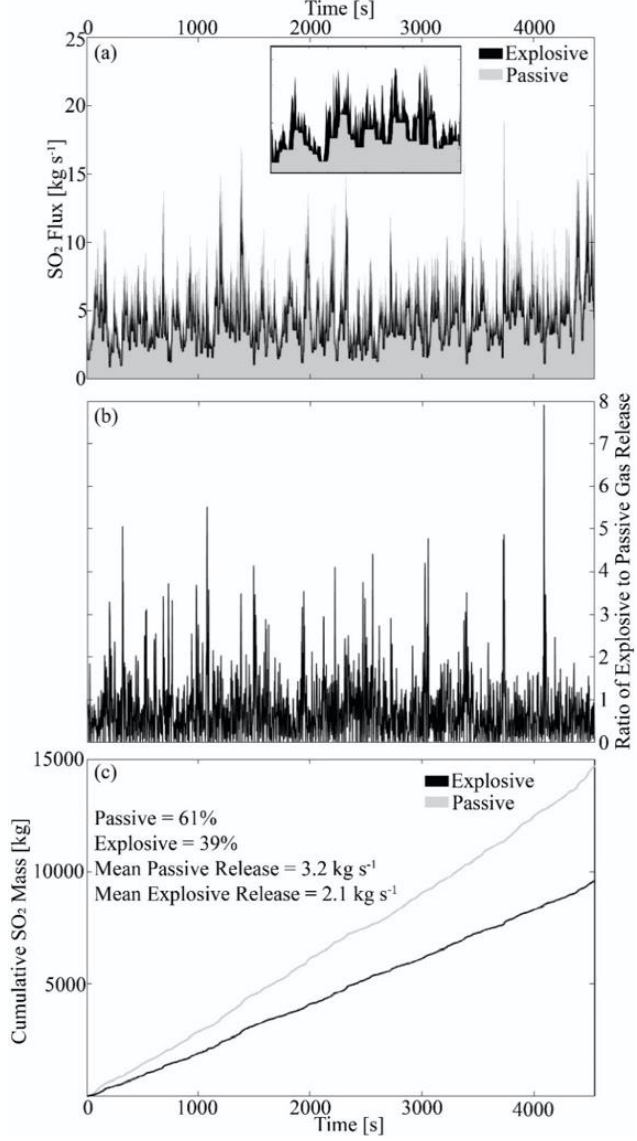
Figure 7. ( a ) Separation of passive and explosion gas release for a period on the 7th July with (inset) an enhanced illustration of the simple statistical moving-minimum-based model, showing oscillation in the passive background degassing overtopped by explosive contributions. ( b ) The ratio of passive-to-explosive degassing and ( c ) a cumulative plot showing the division between passive and explosive gas release. Here, passive and explosive releases have been cumulatively summed to show the change through time at the sampling frequency. The passive-to-explosive ratio is the ratio of the final sum of the gas